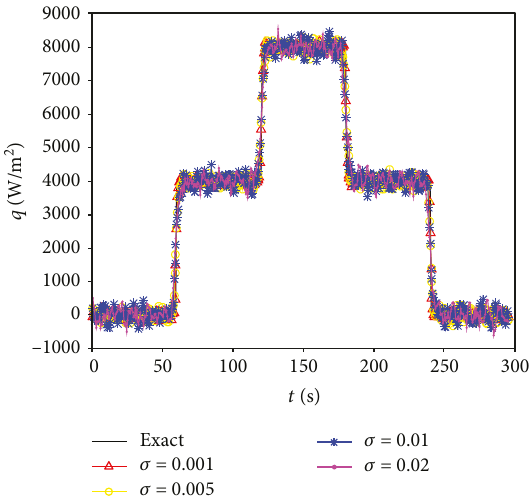
Figure 11: Impacts of di ff erent measuring errors on inversion results when L = 0 01 m and R = R Table 4: Relative average error of inversion results of di ff erent measuring errors when L = 0 01m and R = R